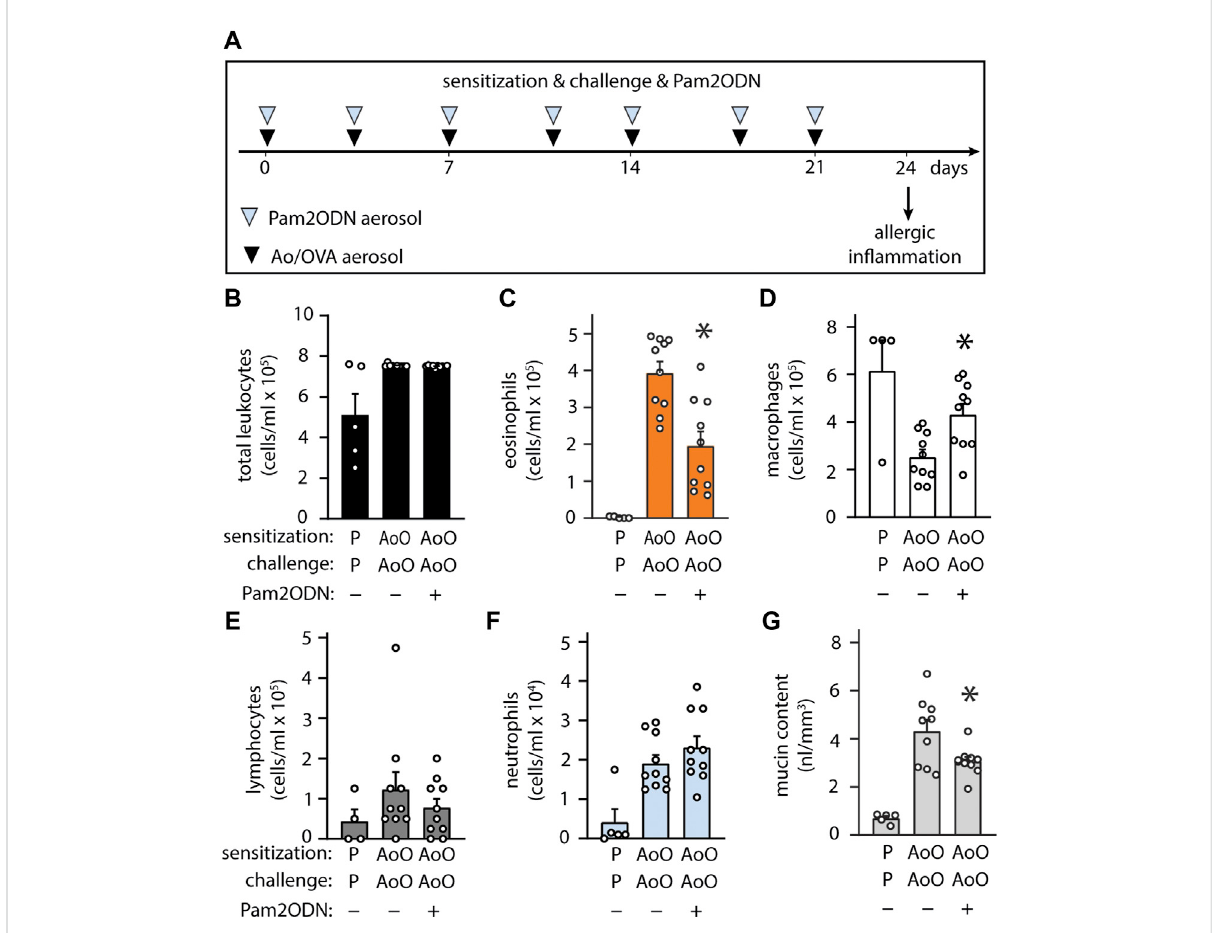
FIGURE 5 Exposure to Pam2-ODN prevents allergic in fl ammation to Aspergillus oryzae. (A) Ao-OVA experimental paradigm with a single aerosol challenge of 10 µg Ao and 2.5% OVA administered together, and repeated 7 times up for up to 21 days, at a regular interval between treatments. Pam2ODN was delivered as a separate aerosol treatment immediately before Ao-OVA with dedicated hardware. (B – E) Quanti fi cation of leukocytes in lung lavage for (B) total leukocytes (C) eosinophils, (D) lymphocytes, (E) macrophages, and (F) neutrophils (N = 4-9 mice). (G) Quanti fi